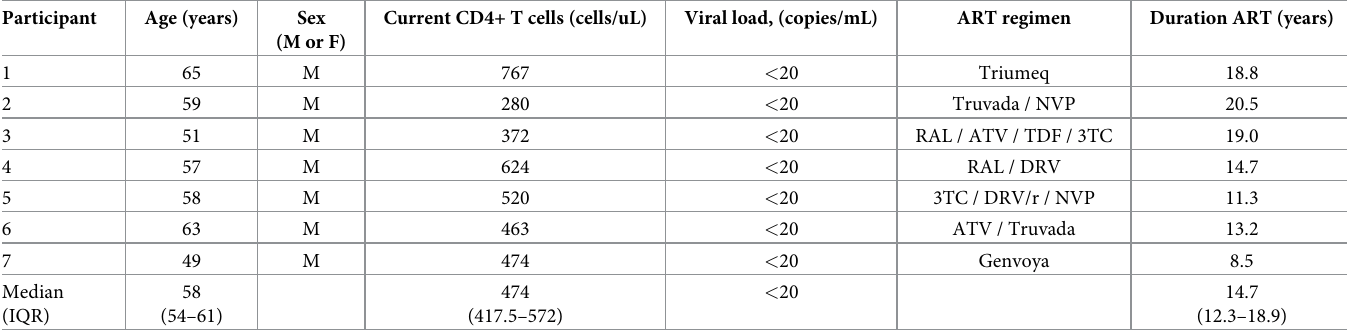
Table 1. Demographics of PLWH who provided blood for the ex vivo experiments. Triumeq = abacavir / lamivudine / dolutegravir; Truvada = tenofovir disoproxil fumarate / emtricitabine; NVP = Nevirapine; RAL = Raltegravir; ATV = Atazanavir; TDF = Tenofovir = tenofovir disoproxil fumarate; 3TC = lamivudine; DRV = Darunavir; RTV = Ritonovir; DRV/r–Darunavir/ritonavir; Genvoya = tenofovir alafenamide / emtricitabine / elvitegravir /